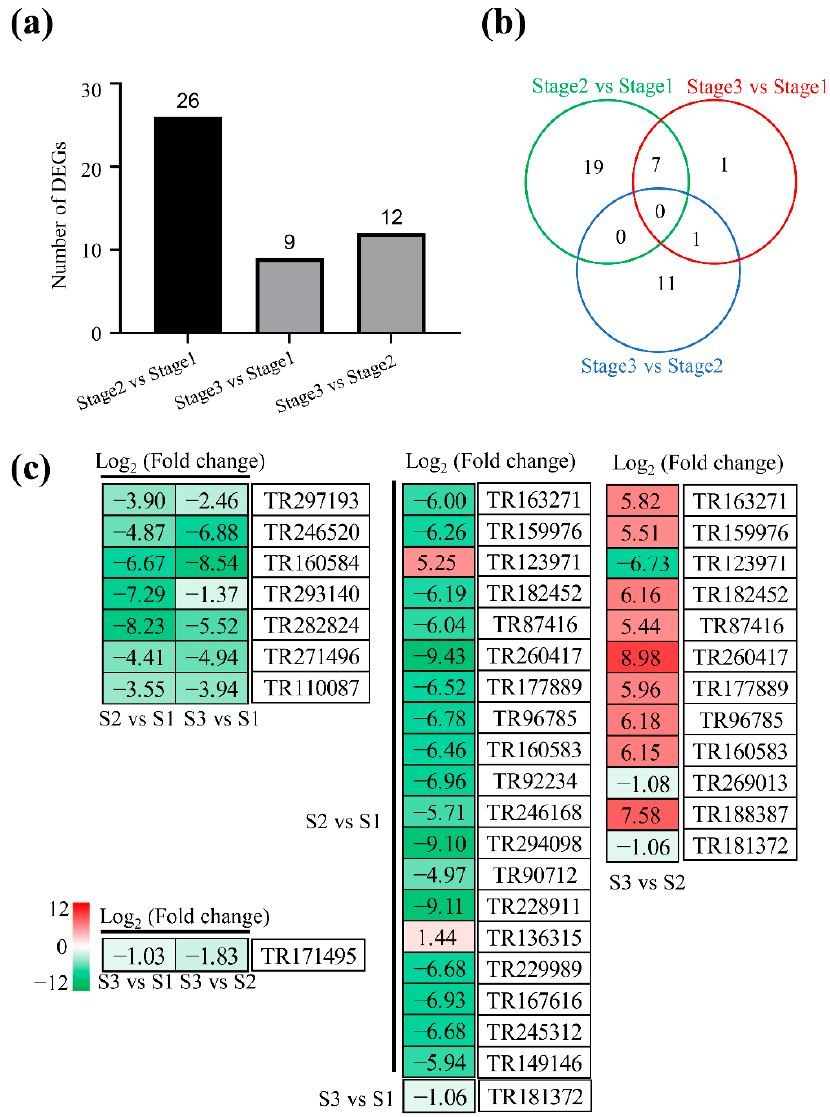
Figure 7. Analysis of differentially expressed genes involved in translation. ( a , b ) Summary of differentially expressed genes at stage 1, stage 2, and stage 3. ( c ) The list of differentially expressed genes. Red and green represent up-regulated and down-regulated, respectively.